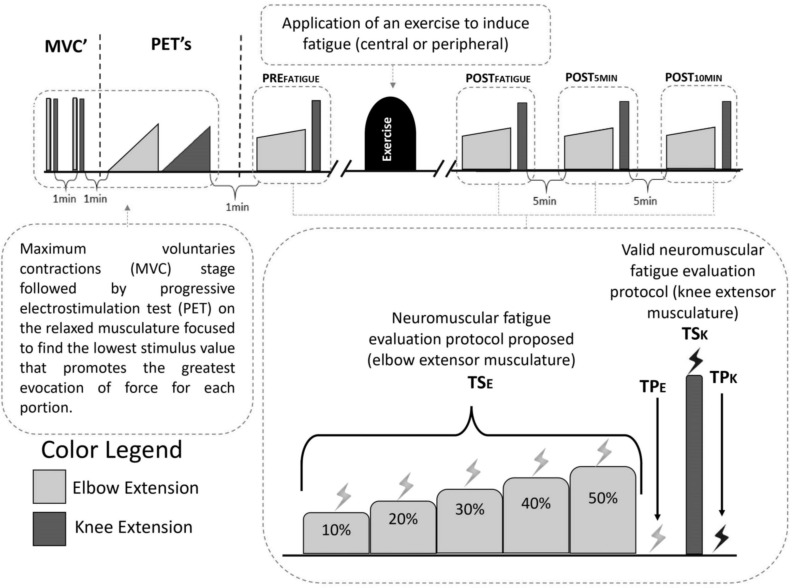
Experimental design adopted in this study. Measurements made on the elbow extensor musculature are illustrated in light gray and measurements made on the knee extensor musculature are illustrated in dark gray. The experimental steps included: assessment of maximum voluntary contraction (MVC), progressive test of electrostimulation (PET) to establish the best value for stimulation and pre and post-exercise evaluations. The evaluations included: for elbow extensor musculature, submaximal contractions maintained in 10, 20, 30, 40, and 50% of the MVC on elbow extensor musculature with stimulus applied to each maintained force (TSE) and another stimulus applied with the relaxed musculature at the end of the submaximal task (TPE); for knee extensor musculature, a maximum contraction accompanied by a stimulation (TSK) followed by another stimulation applied to the relaxed musculature (TPK).